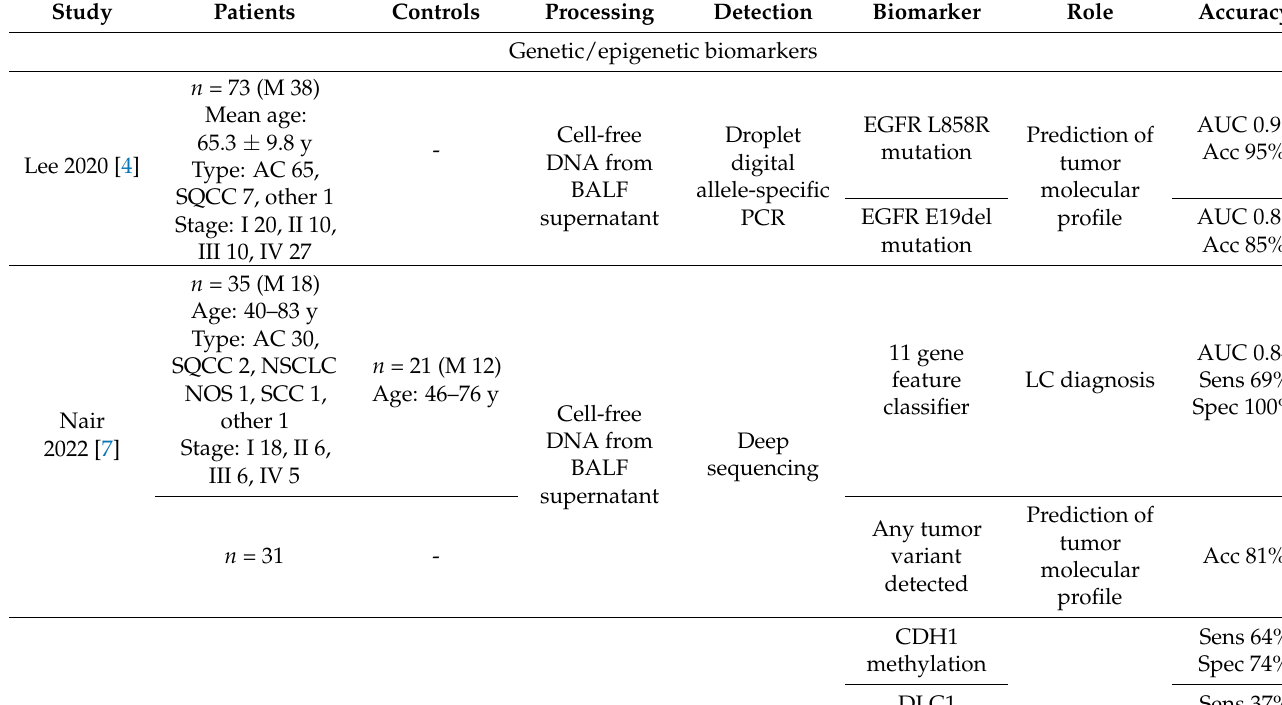
Table 1. Overview of lung cancer biomarkers, their measurement methods in bronchoalveolar lavage fluid, their respective diagnostic/predictive roles, and accuracy results from studies included in the